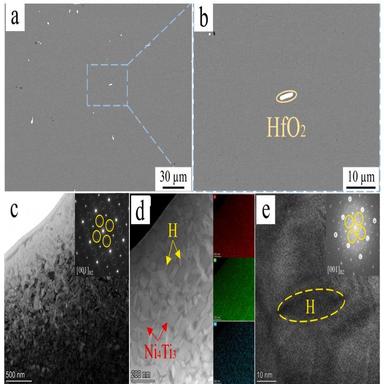
Microscopic morphology of Ni55Ti37Hf8 alloy after heat treatment at 500 ℃ for 100 h, (a)-(b) SEM morphology, (c) Low-magnification TEM morphology, (d) HADDF morphology with corresponding elemental mapping of Ni (red), Ti (green), and Hf (blue), (e) High-resolution morphology of matrix.